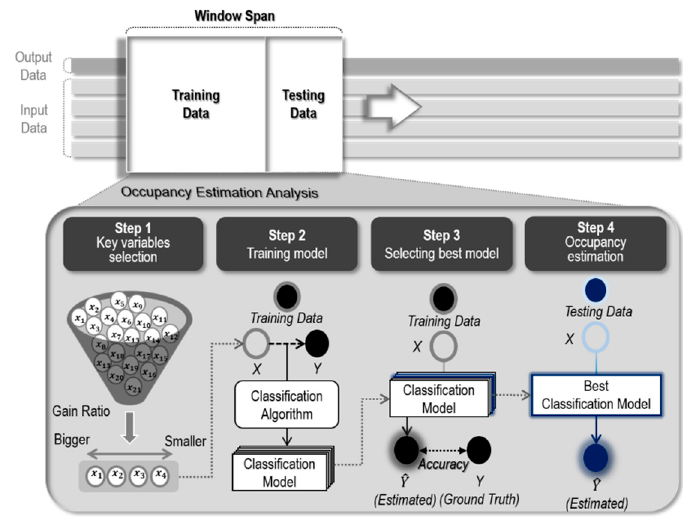
Figure 6. Diagram of the consecutive long-term occupancy estimation framework.